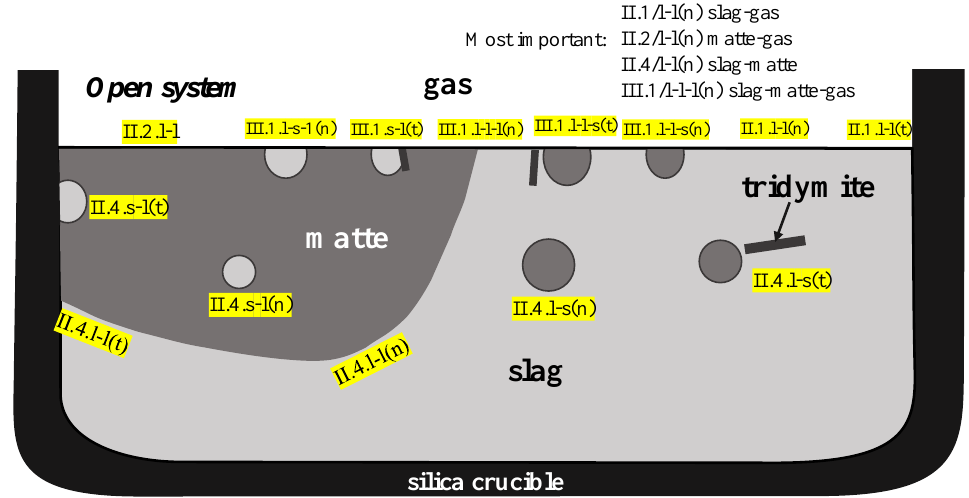
Figure 9. Schematic diagram for classification of macro- and micro-locations in the open system.